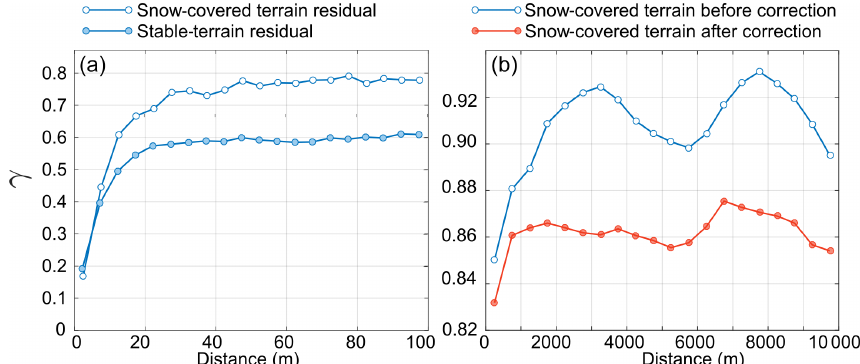
Figure 9. (a) Semivariogram or spatial autocorrelation ( γ ) against lag distance of the HS residuals (empty circles) and Pléiades elevation difference over stable terrain (filled circle). (b) Semivariogram of the HS residuals for large distances before (blue line) and after correcting the undulation pattern (red line), illustrating the reduction in spatial variance at greater lag distances due to this correction (Sect. 6.5).